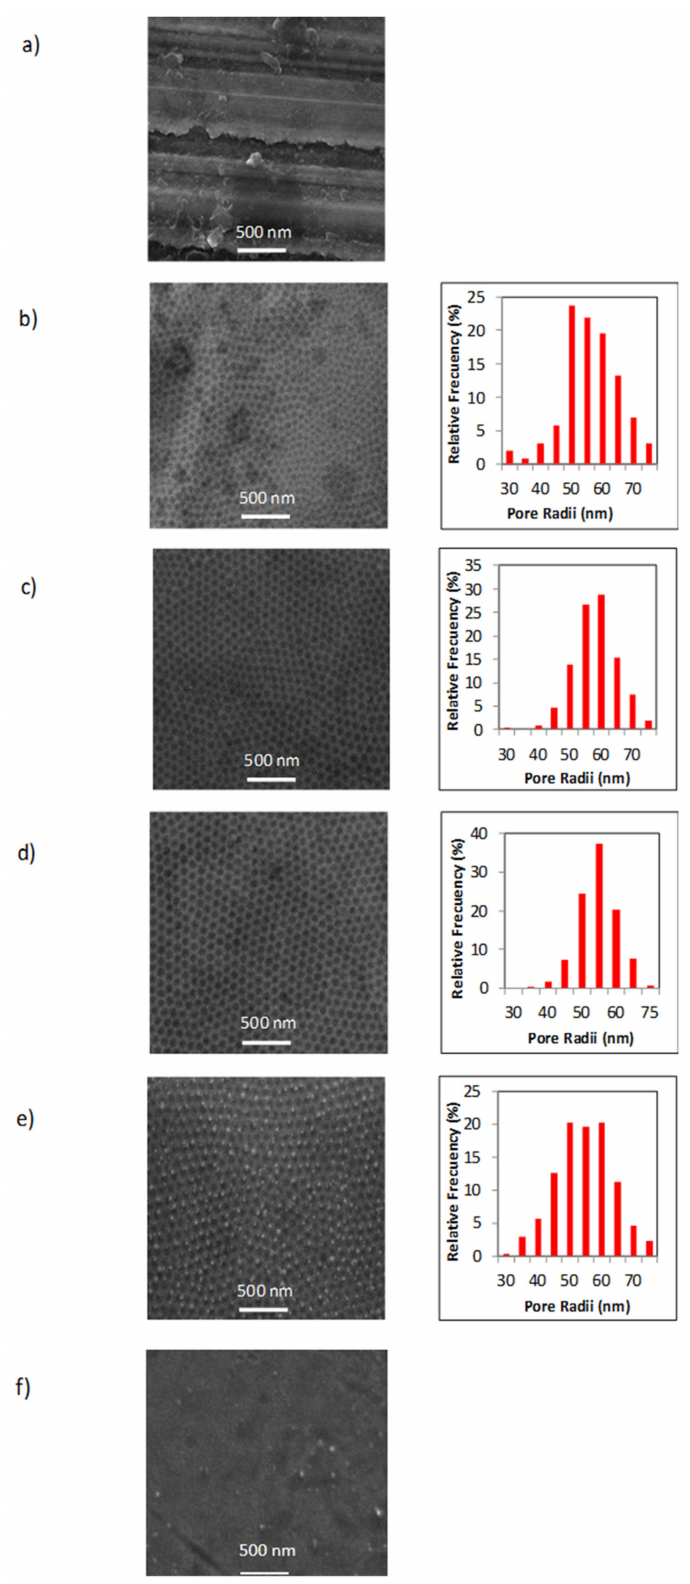
Figure 3. SEM top surface views corresponding to the sample S1 ( a ), sample S2 ( b ), sample S3 ( c ), sample S4 ( d ), sample S5 ( e ), and samples with AgNPs plus TiO 2 films with different proportions (samples S6-S8) ( f ). The respective histograms show the pore radii distribution obtained from each SEM micrograph, ranging between 50 and 60